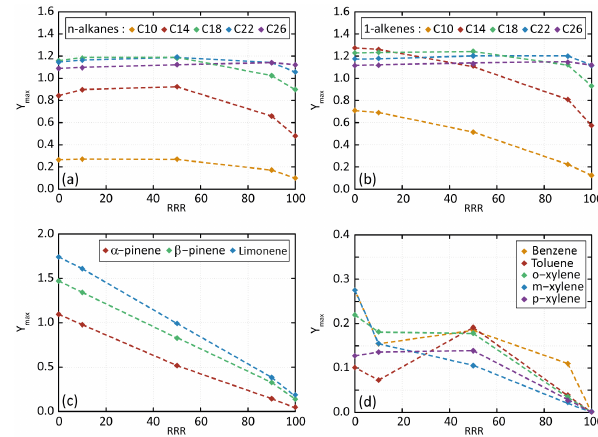
Figure 4. Dependence of Y max on RRR (here in percent) for n- alkanes (a) , 1-alkene (b) , terpenes (c) and aromatic species (d) for the scenarios performed at a temperature of 298K, a zenith angle of 50 ◦ , a C oa of 1µgm − 3 and 40ppb of ozone. Points are connected with dashed lines to help in seeing trends of Y max with